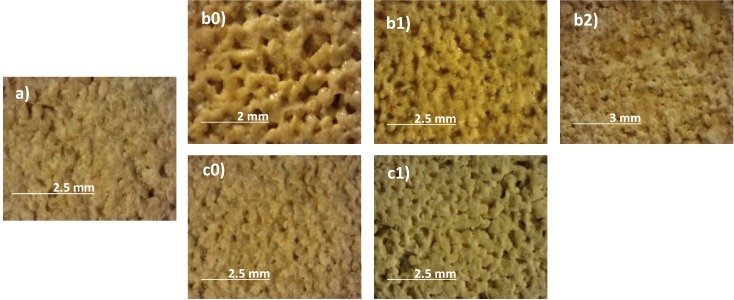
Stereographic microscopy images of the surface of limestone.Untreated (a) and coated with AG1 (b) and AG2 (c): unweathered (0), after 12 months of outdoor exposure (1) and after1500 hours (2) in a QUV chamber.